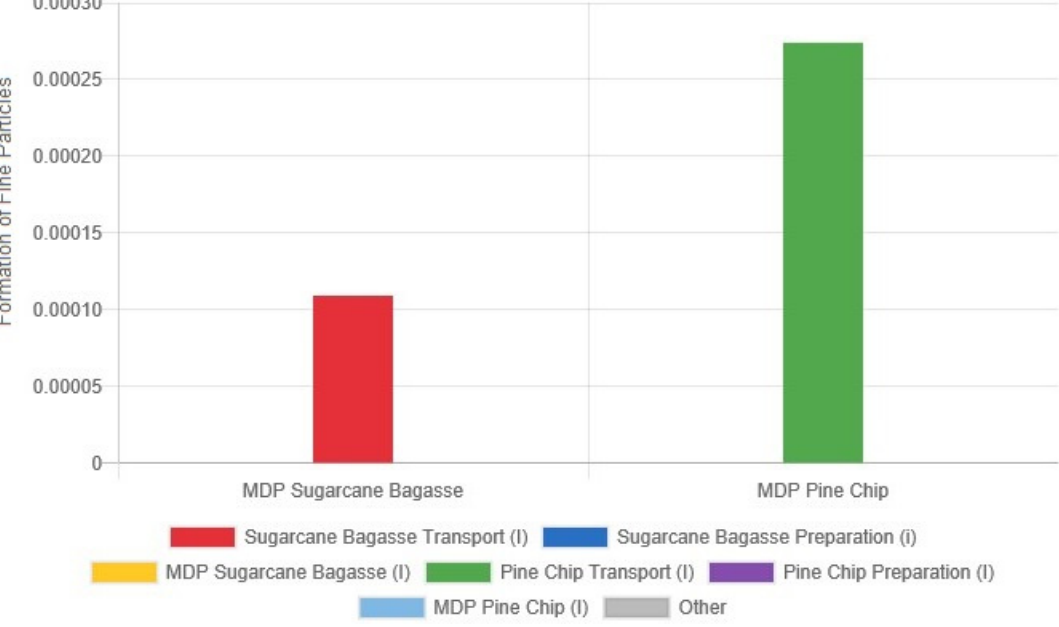
Figure 4. Formation of fi ne particles (kg PM2.5 eq).